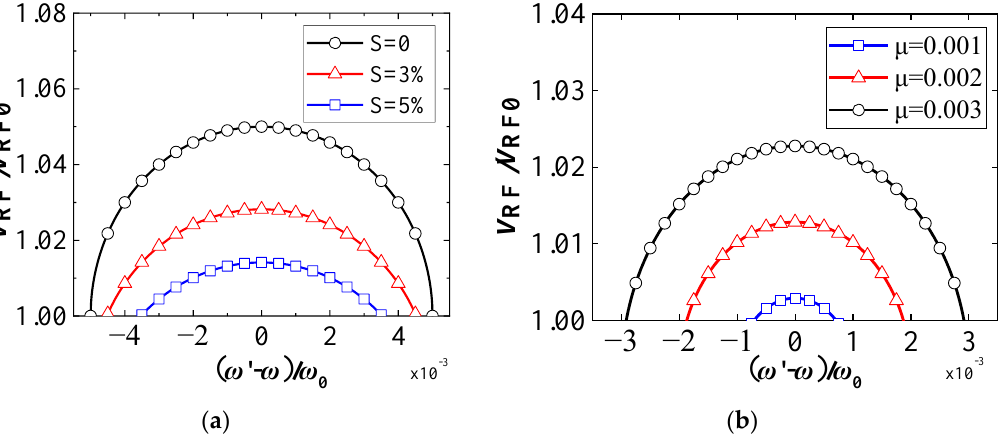
Figure 2. The injection locking performance with respect to the ( a ) power supply ripple S and ( b ) injection amplitude 𝜇 , without the frequency pushing effect 𝛼 .